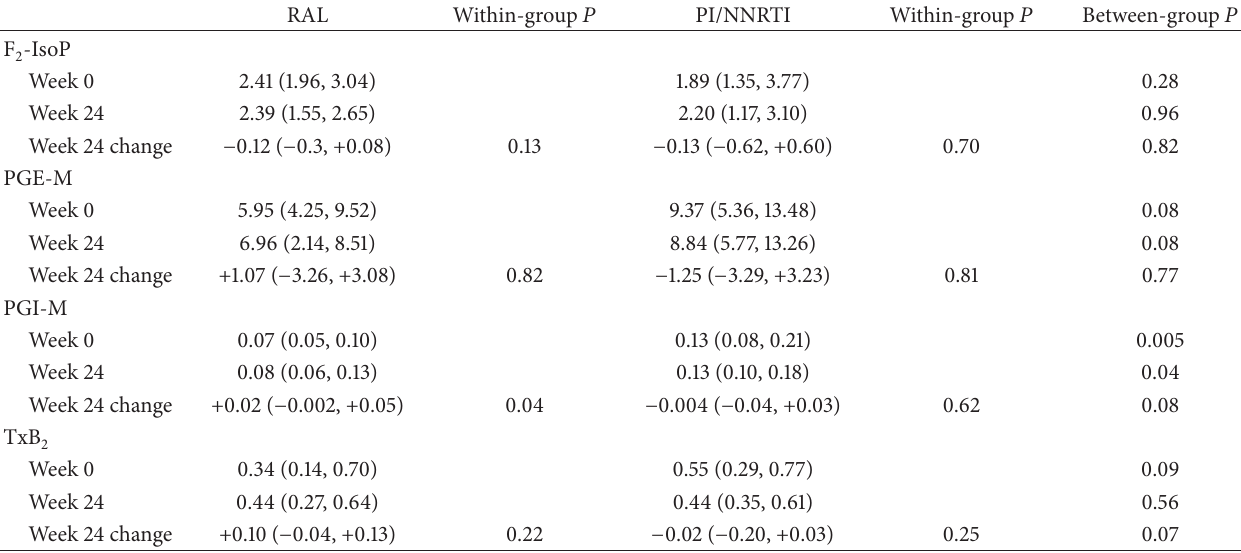
Table 2: Urinary eicosanoid levels- absolute and 24-week changes, by study arm.